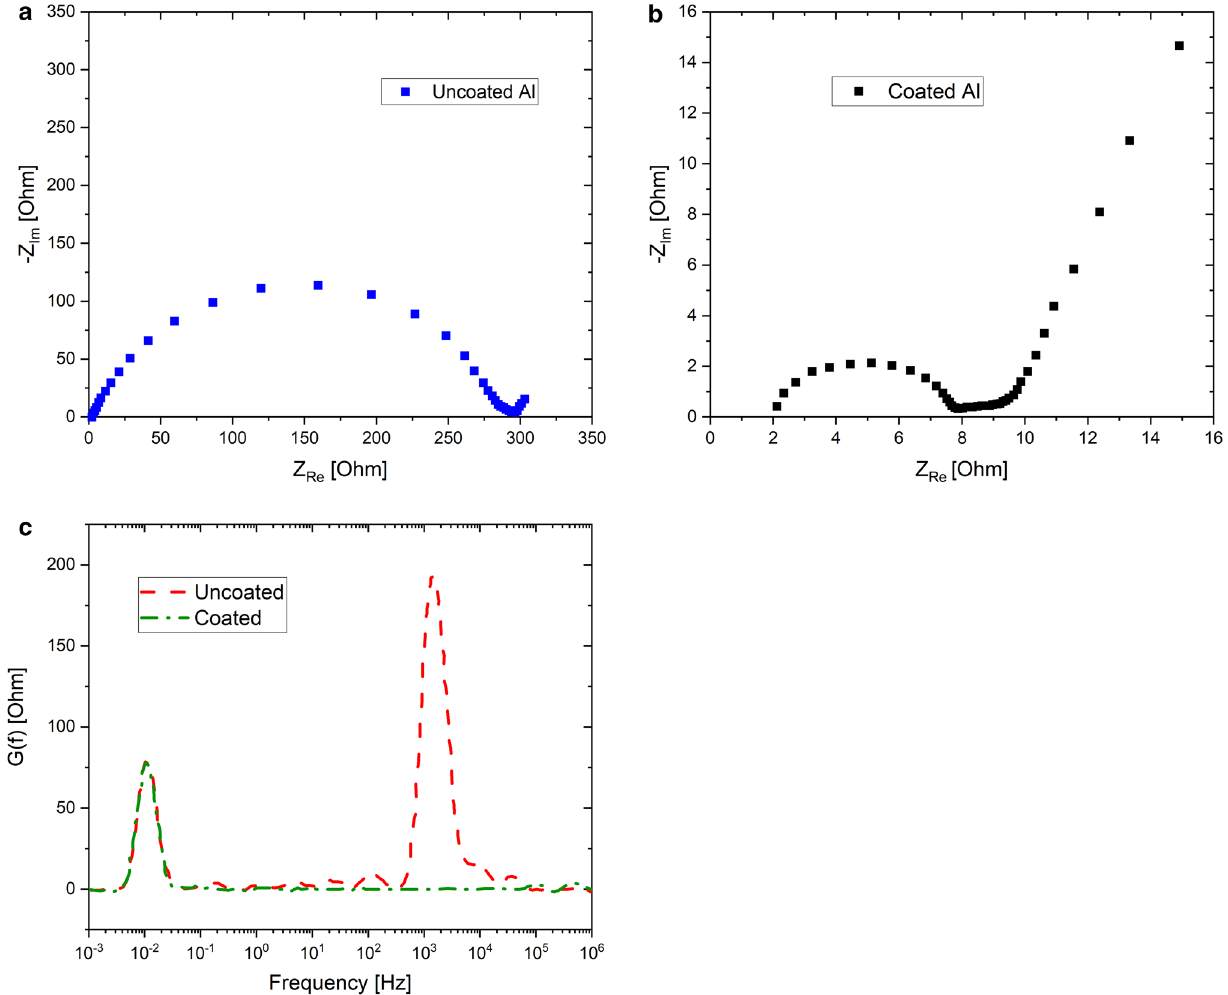
Fig. 4 Electrochemical impedance spectra of a symmetrical cell of LFP cathodes at 50% SOC, on a uncoated foils. b coated foils, and c the distribution of relaxation times, G(f), derived from the impedance spectra of cells with coated and uncoated